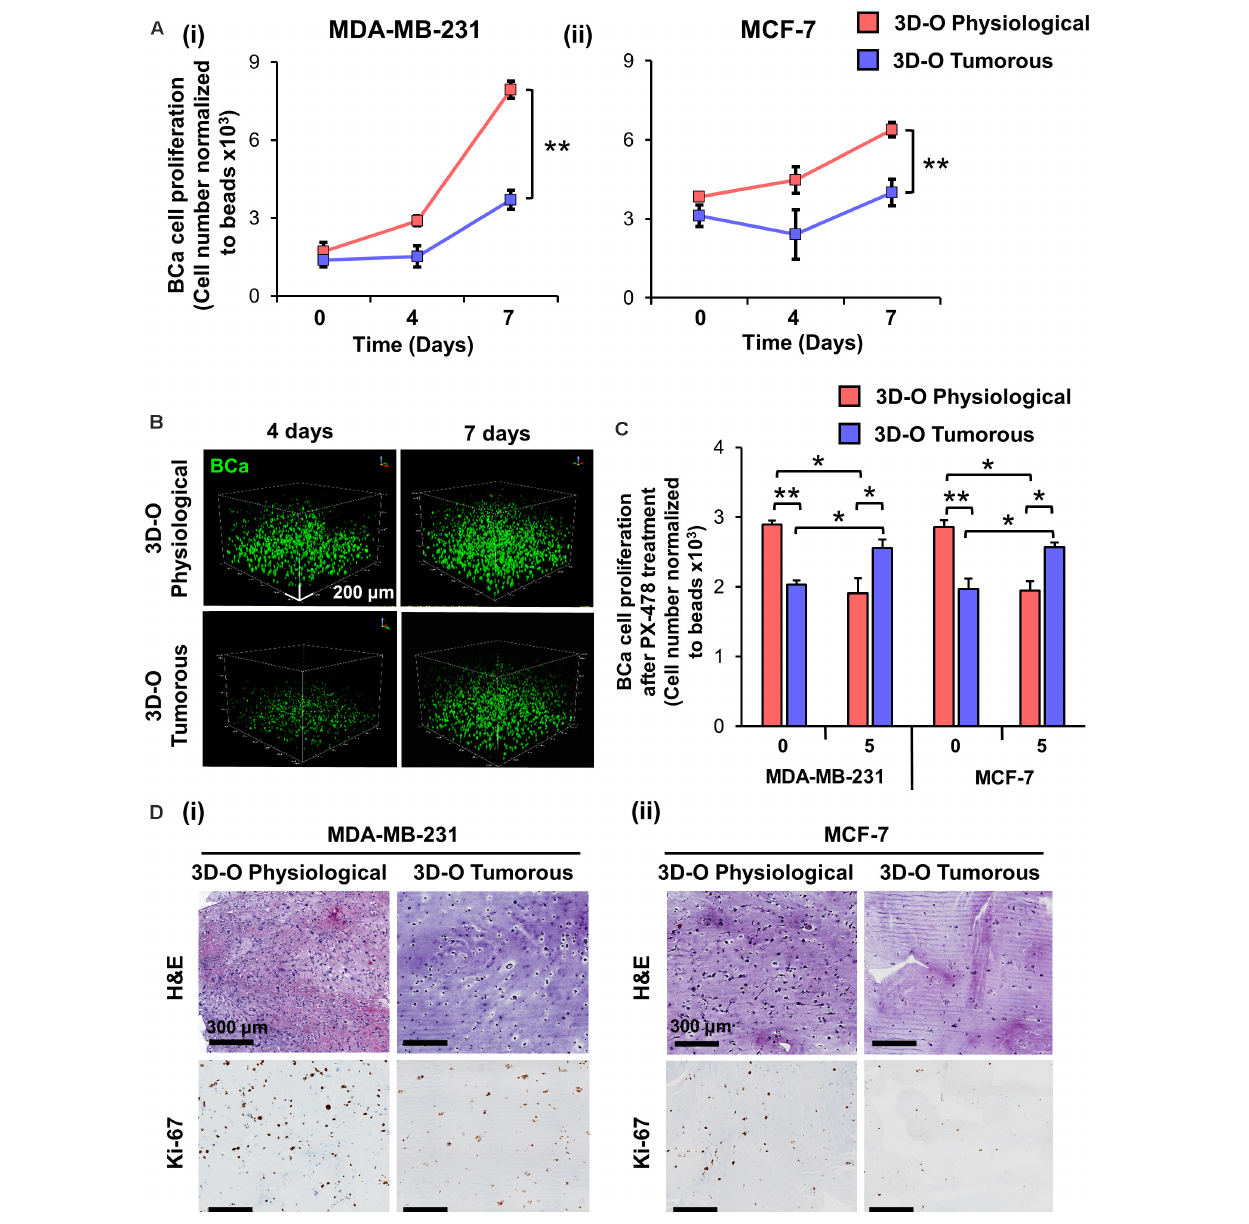
FIGURE 3 | Low-oxygen within 3D-O matrices hinders BCa cell proliferation. (A) Effect of oxygen deprivation on the proliferation of MDA-MB-231 (i) and MCF-7 cells (ii) grown for 7 days either in 3D-O physiological or 3D-O tumorous matrices. (B) Representative confocal microscopy images of MDA-MB-231 cells (green) inside 3D-O matrices at days 4 and 7 represented by z-stack images from top to bottom in rotated view. Scale bar = 200 µ m. (C) Proliferation of MDA-MB-231 and MCF-7 cells after treatment with PX-478 at 5 µ M concentration quantified as cell numbers normalized to beads grown in 3D-O physiological and 3D-O tumorous matrices after 4 days. (D) H&E staining and IHC results representing Ki-67 expression in MDA-MB-231 (i) and MCF-7 cells (ii) grown for 4 days within 3D-O physiological or 3D-O tumorous matrices. Scale bar = 300 µ m., ** p < 0.001, * p < 0.05, data were analyzed using one-way analysis of variance (ANOVA), and unpaired two-tailed Student’s t